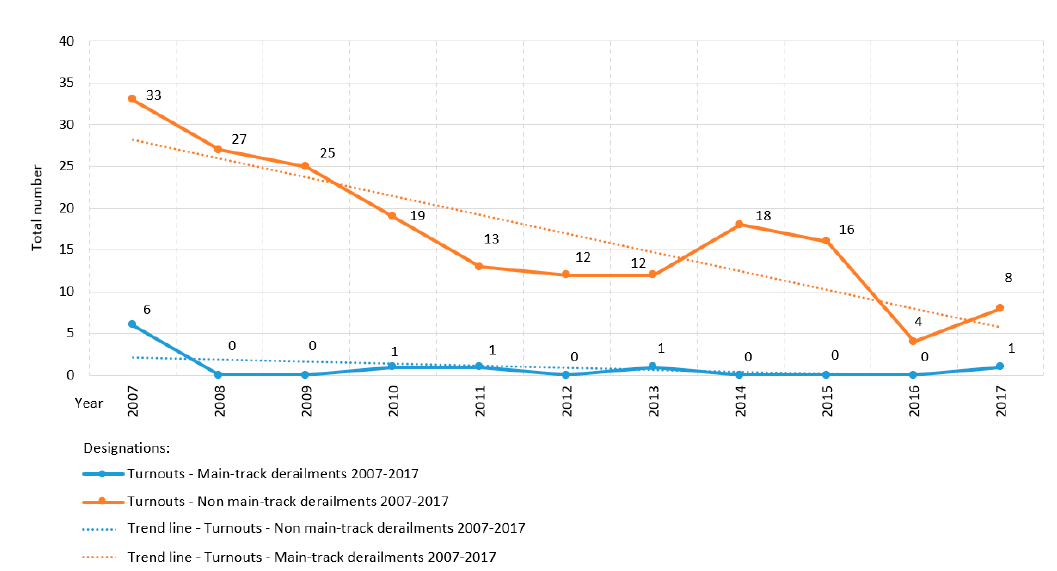
Figure 9. State of derailments at Canadian turnouts in 2007–2017.